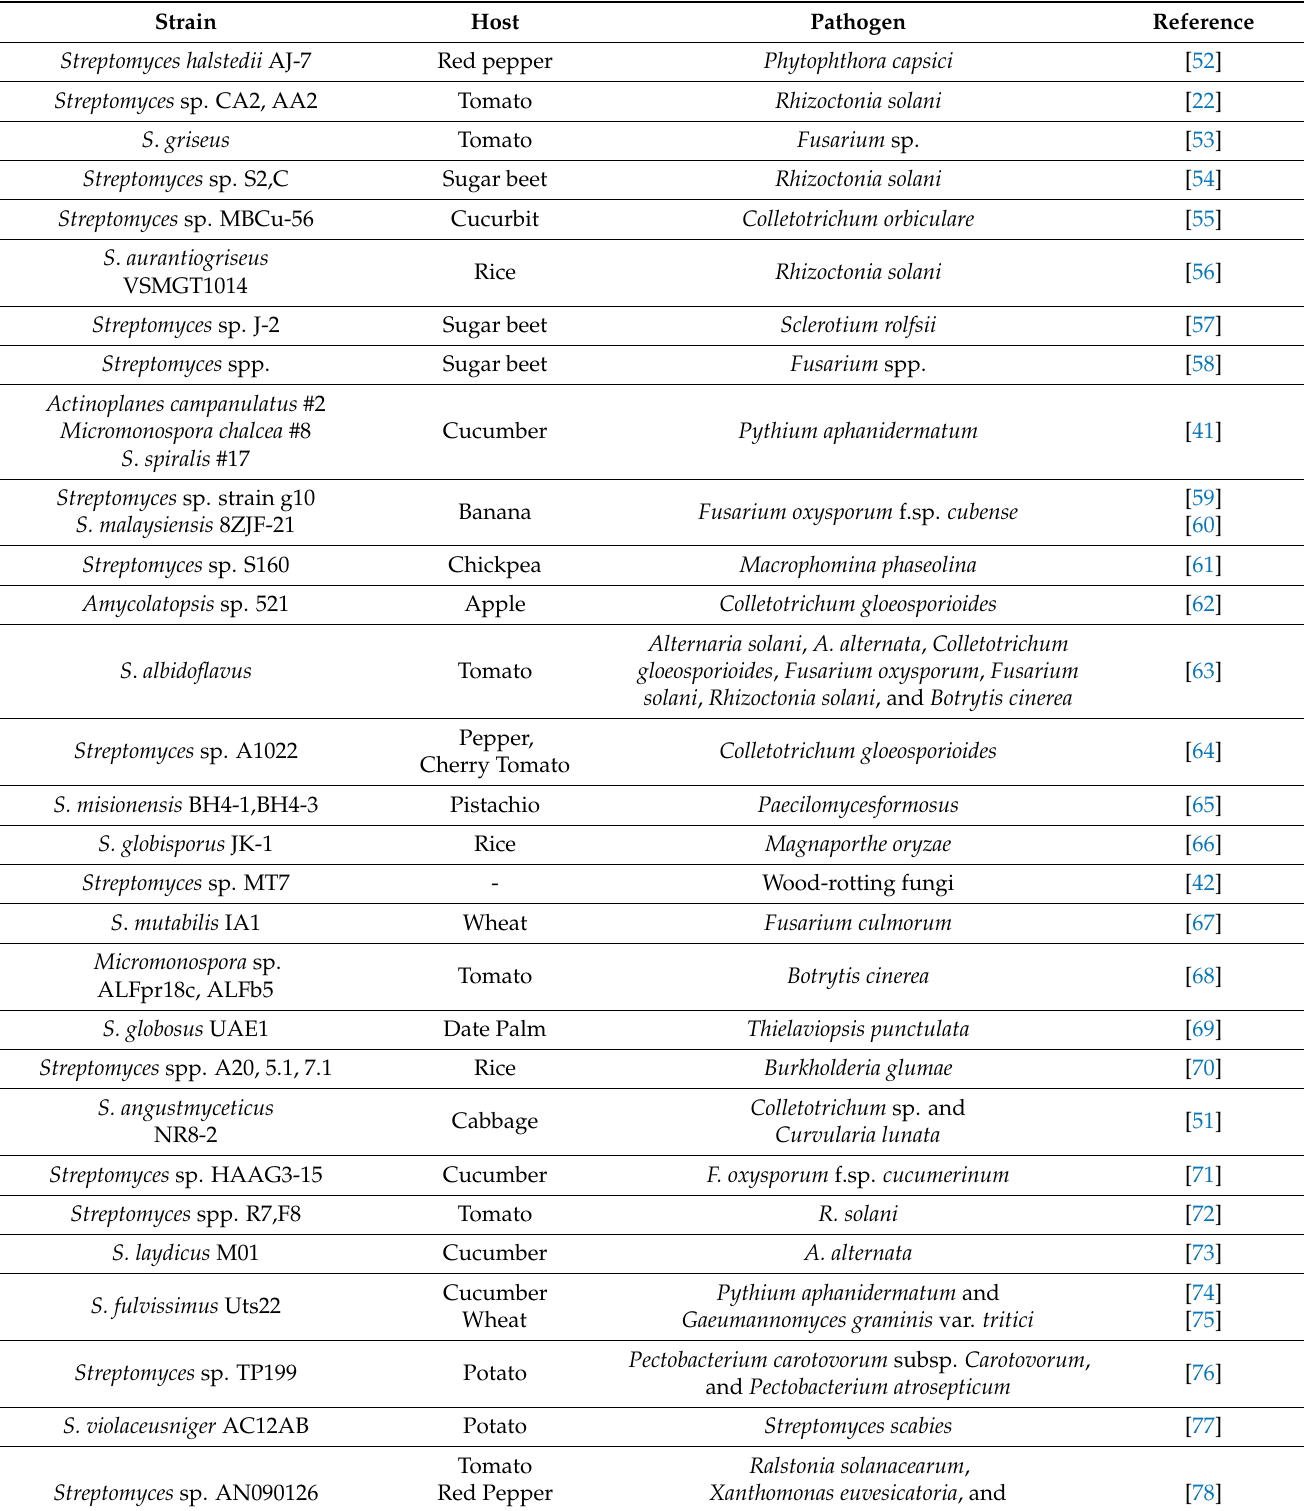
Table 1. The examples of biocontrol activity of the actinobacterial strains against some phytopathogens.